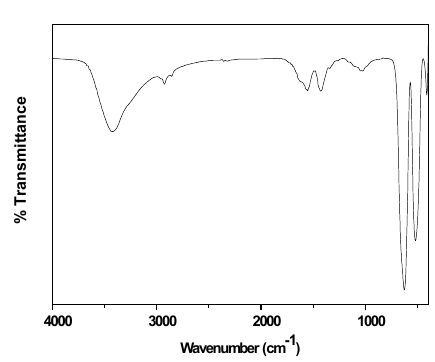
Figure 2. FTIR spectrum of sonochemically synthesized Mn